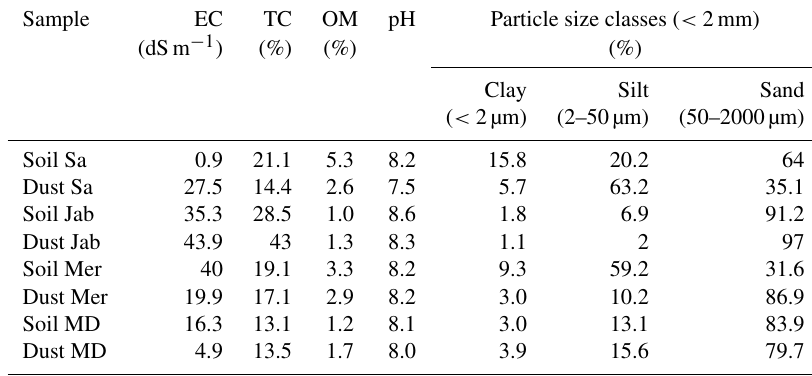
Table 2. Physicochemical properties of the studied natural dust samples and surface-collected soil samples.